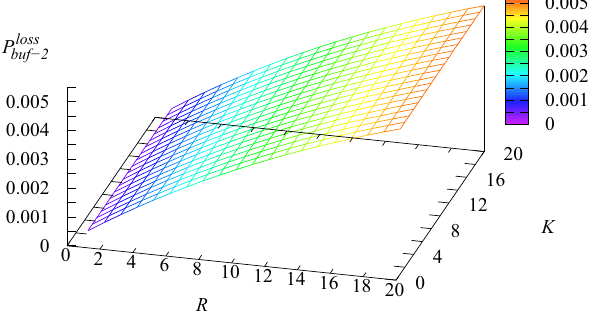
Figure 16. Dependence of loss probability P loss and R .